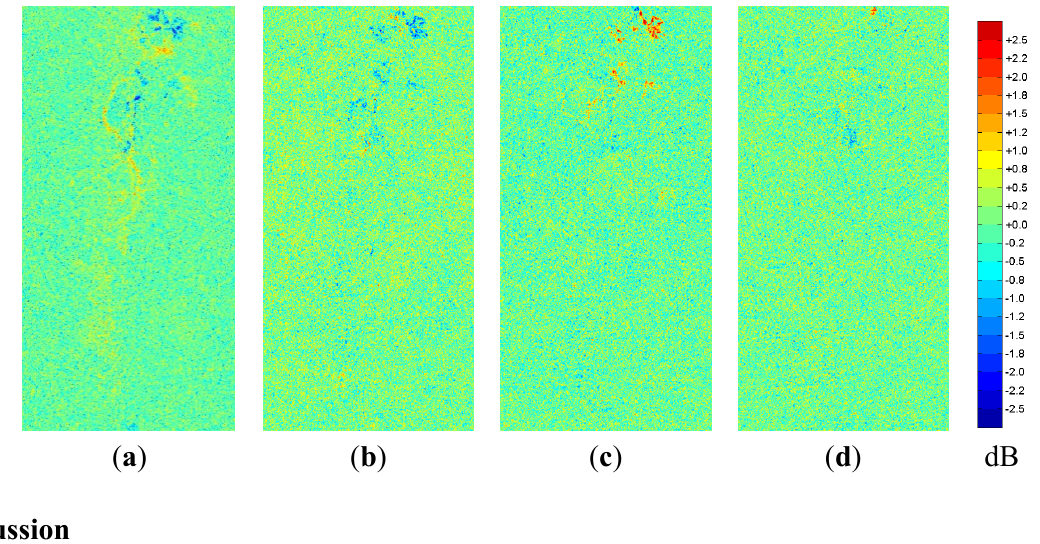
Figure 15. Change in Kennaugh Element k May; ( b ) May to June; ( c ) June to July; and ( d ) July to